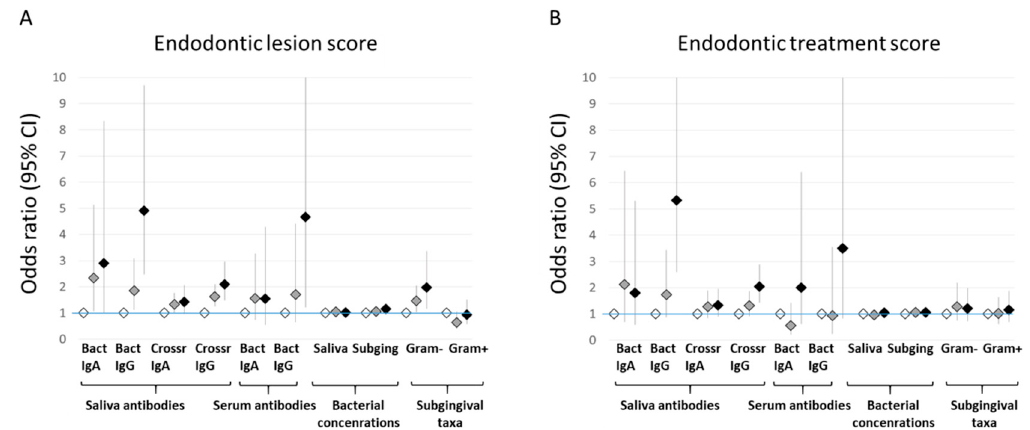
Figure 3. Associations of the antibody and bacterial levels with endodontic lesion score and endodontic treatment score. Endodontic lesion score (A): score I, no endodontic lesions; score II, patients with ≥ 1 widened periapical space and/or 1 tooth with apical periodontitis; and score III, patients with ≥ 2 teeth with apical periodontitis. Endodontic treatment score (B): score I, no endodontic lesions; score II, apical periodontitis only in teeth with root canal fillings; score III, apical periodontitis in teeth without root canal fillings. The associations were investigated by using multinomial regression models adjusted for age, sex, marginal periodontitis (healthy, gingivitis, periodontitis), number of teeth, and smoking (never/ever). The estimates for lowest (reference), middle, and highest scores are depicted with white, gray, and black diamonds, respectively.